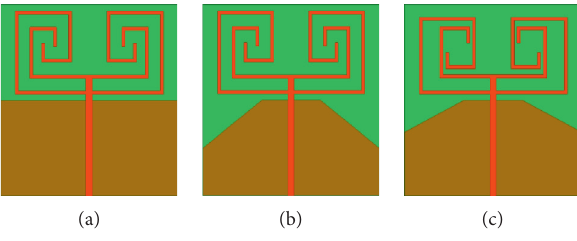
Figure 3: The evolution of antennas.